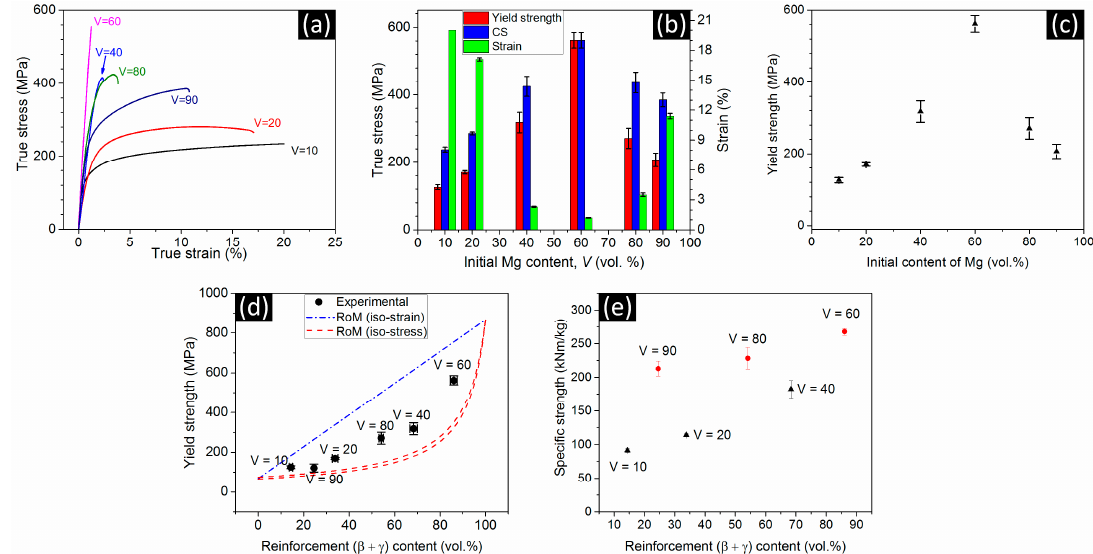
Figure 9. ( a ) The room temperature compression stress-strain curves for the composites with V = 10, 20, 40, 60, 80, and 90 hot-pressed at 673 K and ( b ) summary of the mechanical data. ( c ) Yield strength of the composites as a function of the initial Mg content ( V ). ( d ) Experimental yield strength of the composites as a function of the cumulative amount of β -Al 3 Mg 2 and γ -Al 12 Mg 17 and values calculated using the iso-stress and iso-strain models. The red dashed curves in ( d ) correspond to the iso-stress models with the Mg (lower curve) and Al (upper curve) matrices. The yield strength for the 100 vol % Al 3 Mg 2 + Al 12 Mg 17 in ( d ) is calculated from their hardness values given in References [99,100]. ( e ) Specific strength (compressive strength divided by the density) of the composites as a function of the amount of β -Al 3 Mg 2 + γ -Al 12 Mg 17 .